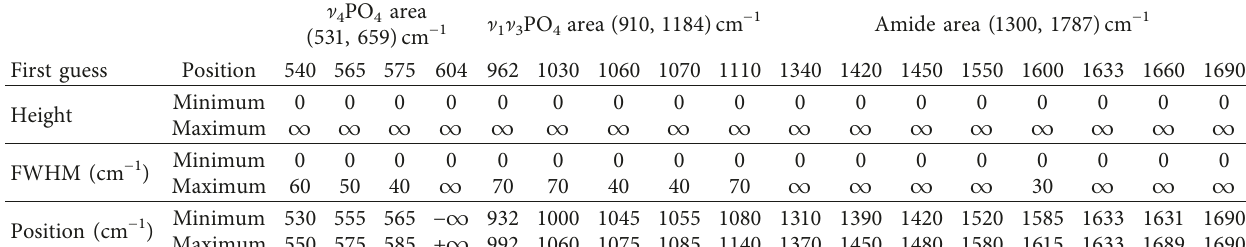
] ] 4 PO 4 area contains 4 peaks, the 1 3 PO 4 area contains 5 peaks, and